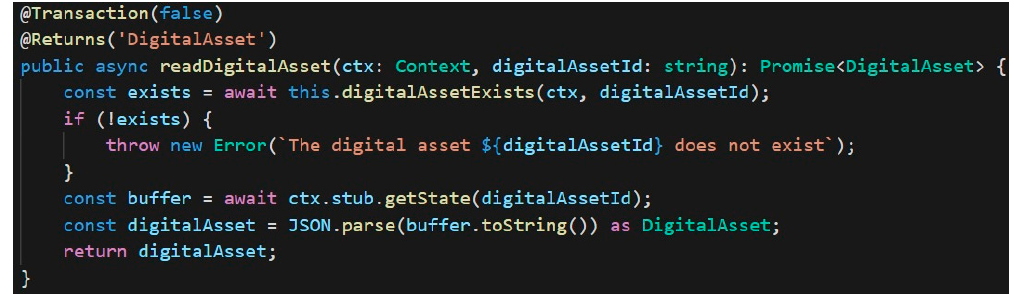
Figure 11. The “readDigitalAsset” transaction example.